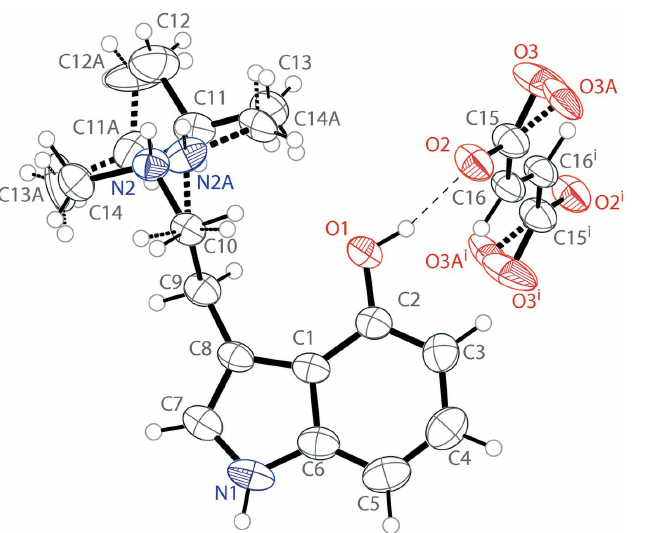
Figure 1 The molecular structure of bis(4-hydroxy- N -isopropyl- N -methyl- tryptammonium)fumarate, showing the atom labeling. Displacement ellipsoids are drawn at the 50% probability level. Hydrogen bonds are shown as dashed lines. Symmetry code: (i) 1 (cid:3) x , 1 (cid:3) y , 1 (cid:3) z .